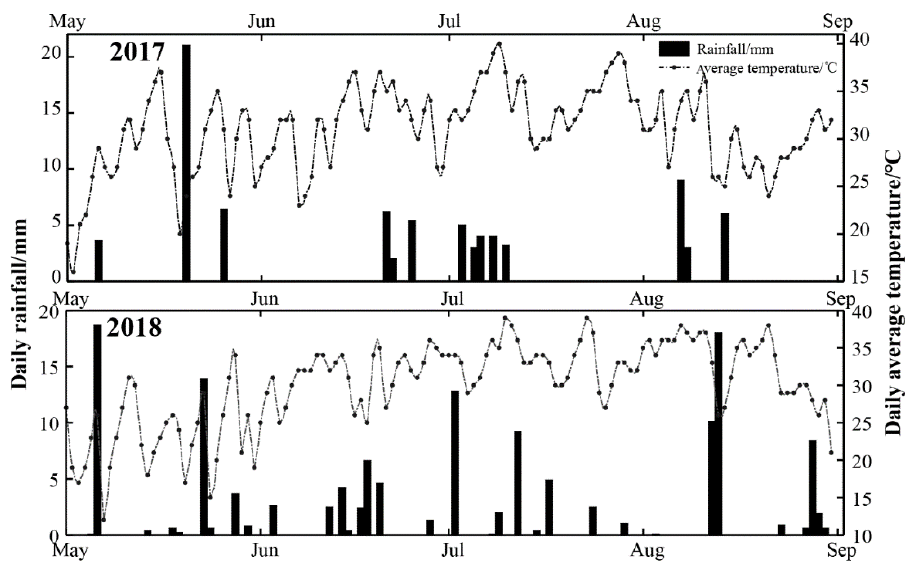
Figure 1. Daily rainfall (mm; black bars) and daily average air temperature (°C; dotted curves) at the study site during the experimental period in 2017 ( upper panel ) and 2018 ( lower panel ).